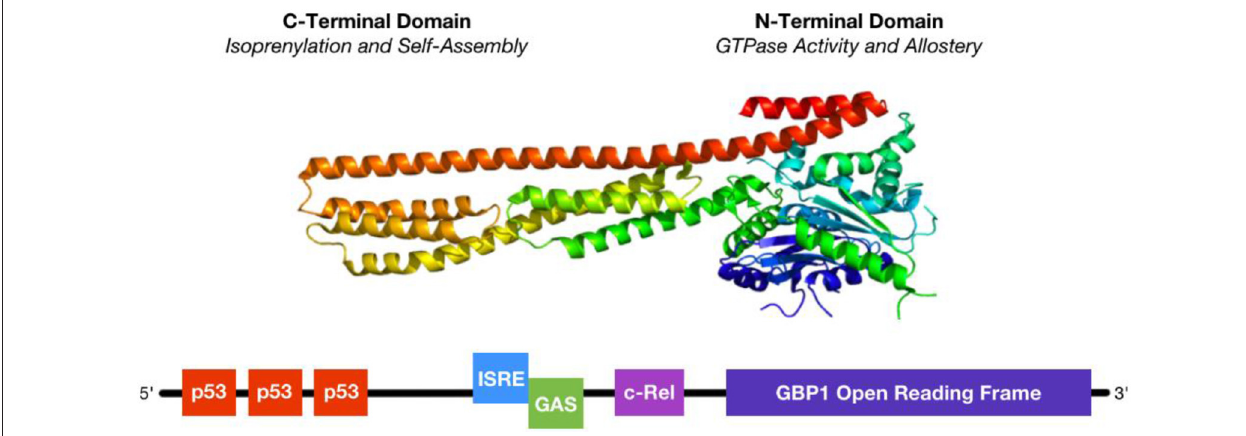
FIGURE 1 | Structure and regulation of GBP1. (Top) GBP1 is a large, 65 kDa GTPase whose activity depends upon homodimerization or tetramerization. Self-assembly is regulated by GTP binding status, where GTP binding initiates activity and self-assembly and either GDP or GMP may bind to the GTPase site as competitive inhibitors. (Bottom) GBP1’s promoter region is regulated by several distinct, but overlapping, transcription factor binding sites. First, 3 p53 responsive elements lay upstream and can be bound by multiple copies of p53 at a time. Second, the ISRE (interferon-stimulated response element) site can be occupied by IRF1, IRF9, or STAT1 singly or in dimers, similar to the downstream GAS ( γ -interferon activation site), following stimulation with either IFN α or IFN γ . Third, the c-Rel site preferentially binds to the p50 sub-unit of NF κ B, whose lack of a transactivation domain suggests functional heterodimerization with other transcription factors. Binding of multiple transcription factors yields additive